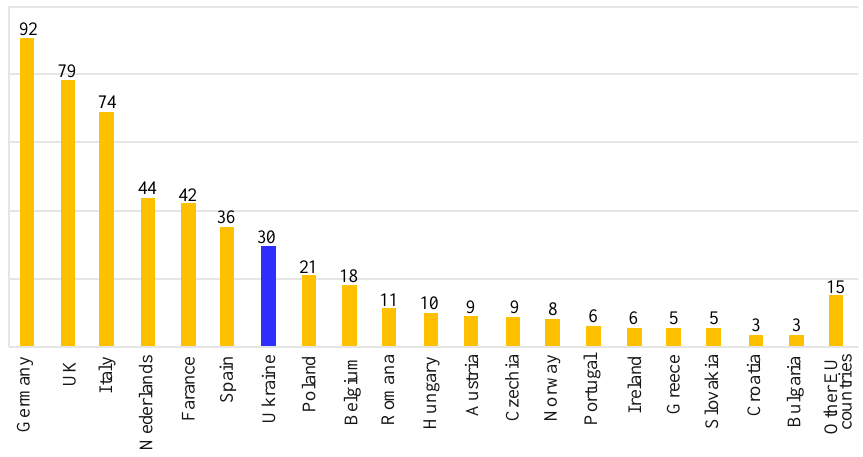
Figure 3. Volumes of natural gas consumption by European countries (billion m 3 ) in 2019.